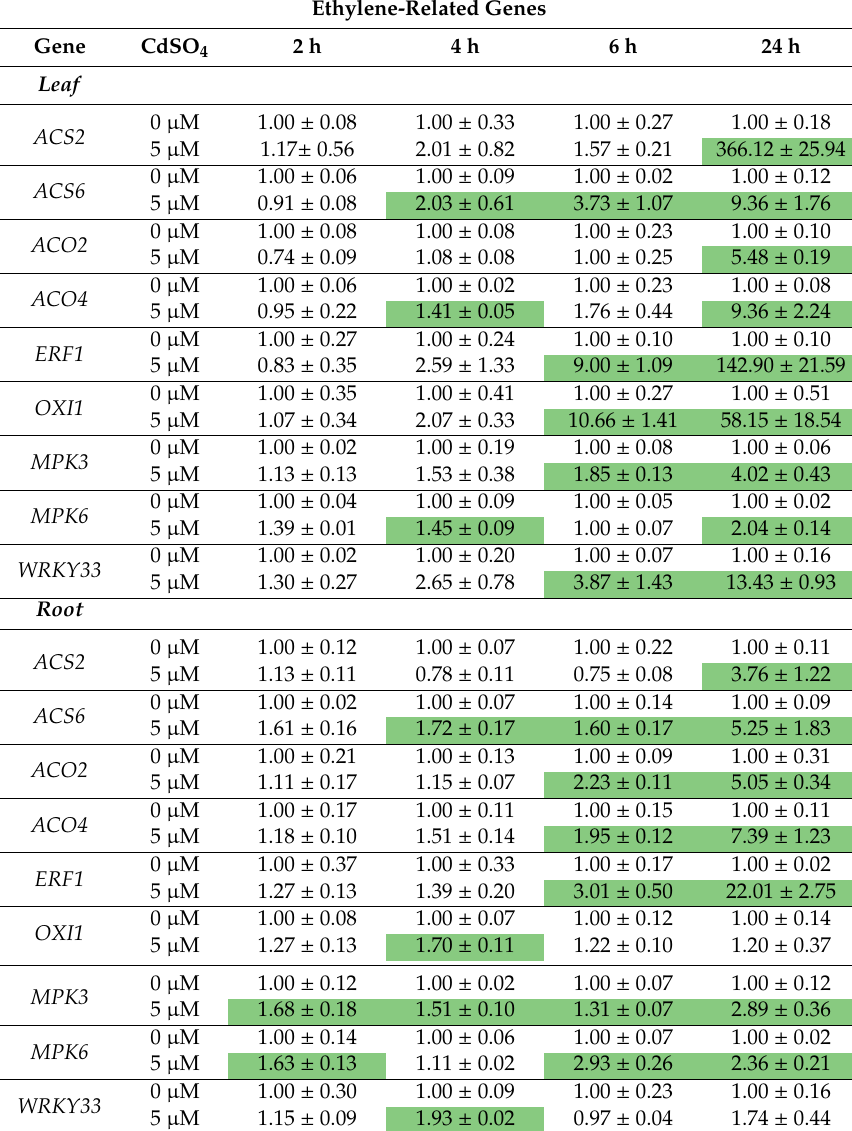
Table 2. Transcript levels of glutathione (GSH)-related genes in leaves and roots of Arabidopsis thaliana plants grown under control conditions (0 μM CdSO 4 ) or exposed to 5 μM CdSO 4 during 2 h, 4 h, 6 h and 24 h. For each time point, data are given as the mean ± S.E. of four biological replicates relative to the control set at 1.00. Significant differences ( t -test: p < 0.05) between control and exposed plants, within each time point, are marked in colour (upregulated: ). GSH1 : γ - glutamylcysteine synthetase; GSH2 : GSH synthetase; GR1 : glutathione reductase; GGT1 : γ -glutamyl transpeptidase 1; ZAT6 : zinc finger of Arabidopsis thaliana 6.